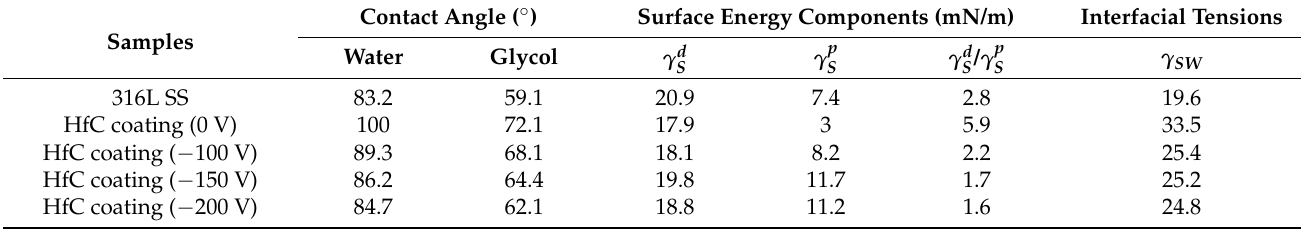
Table 3. Contact angle, surface energy of the HfC coatings, and interfacial tensions with water and glycol.